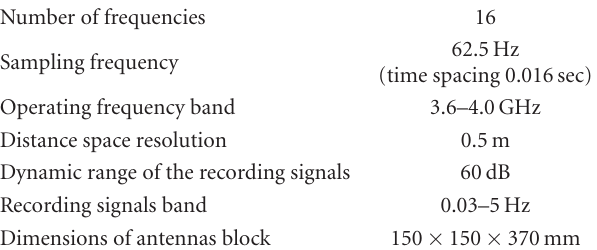
Table 1: Parameters of the radar